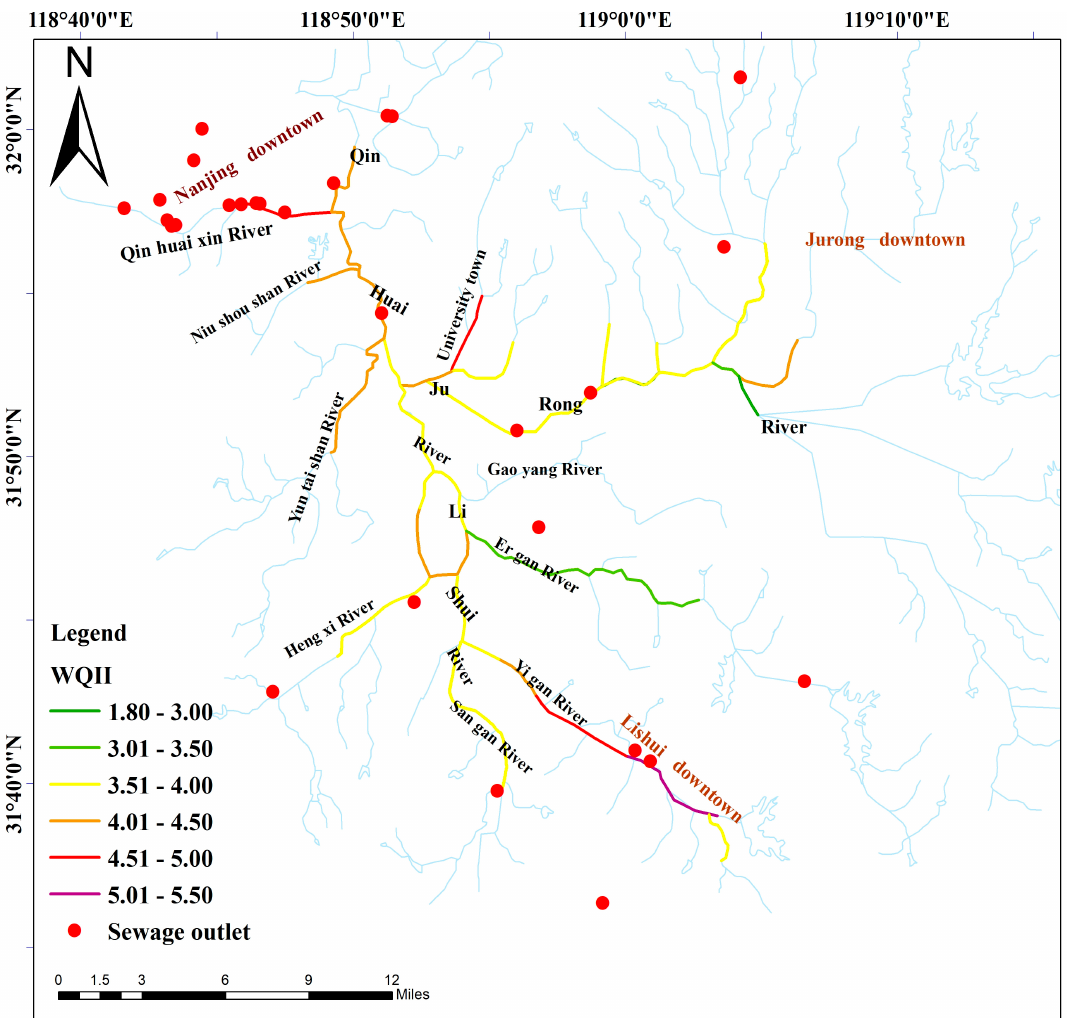
Figure 4. Spatial distribution of water quality identification indices (WQIIs) in the Qinhuai River, East China. The map was created using